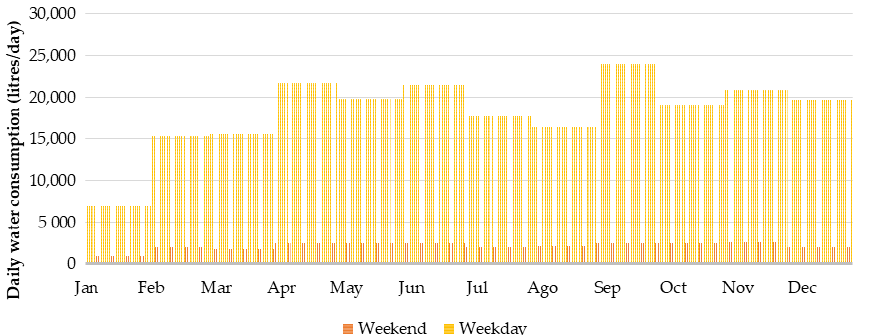
Figure 6. Daily water consumption in Technology Centre building considered in the computer